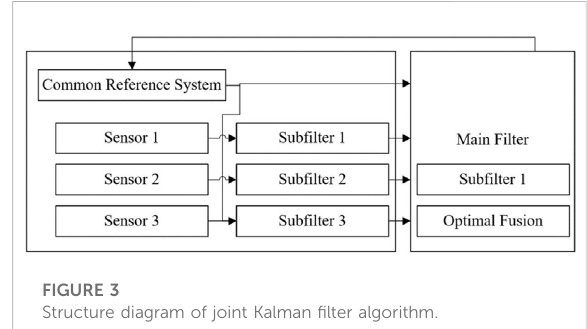
FIGURE 3 Structure diagram of joint Kalman fi lter